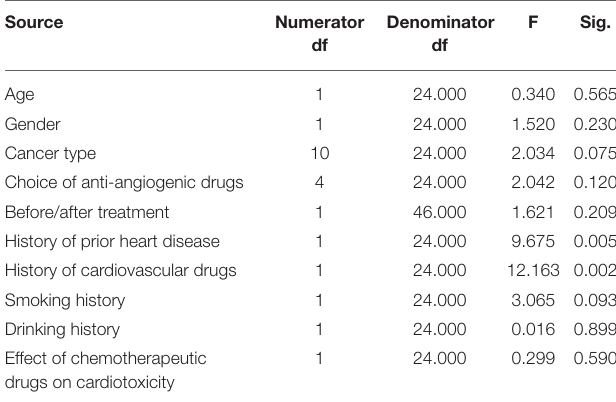
TABLE 3 | Type III test of fixed effects of AST.